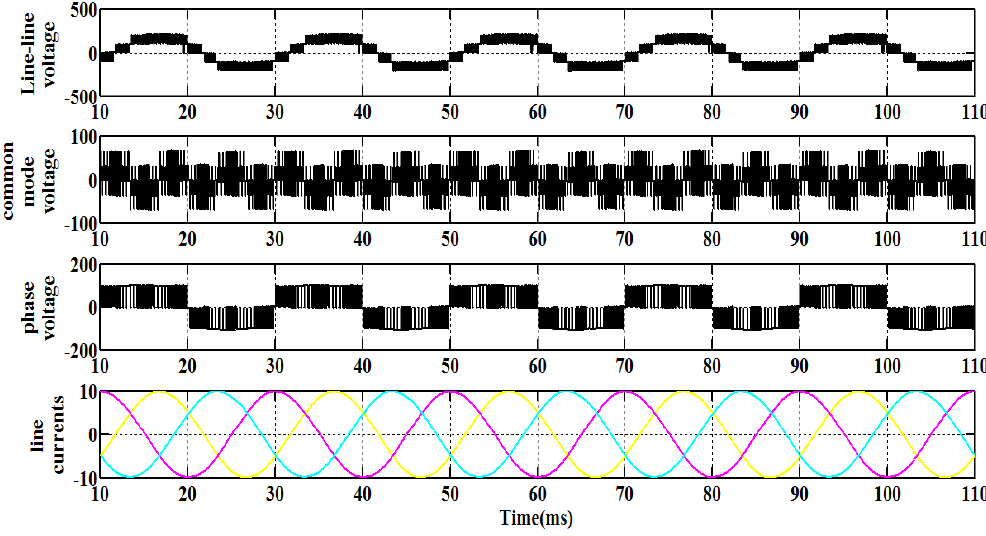
Figure 12. Simulated output waveforms of the transistor clamped ZSI, with M = 1*1.15, To / T = 0, fc = 5.5 kHz.